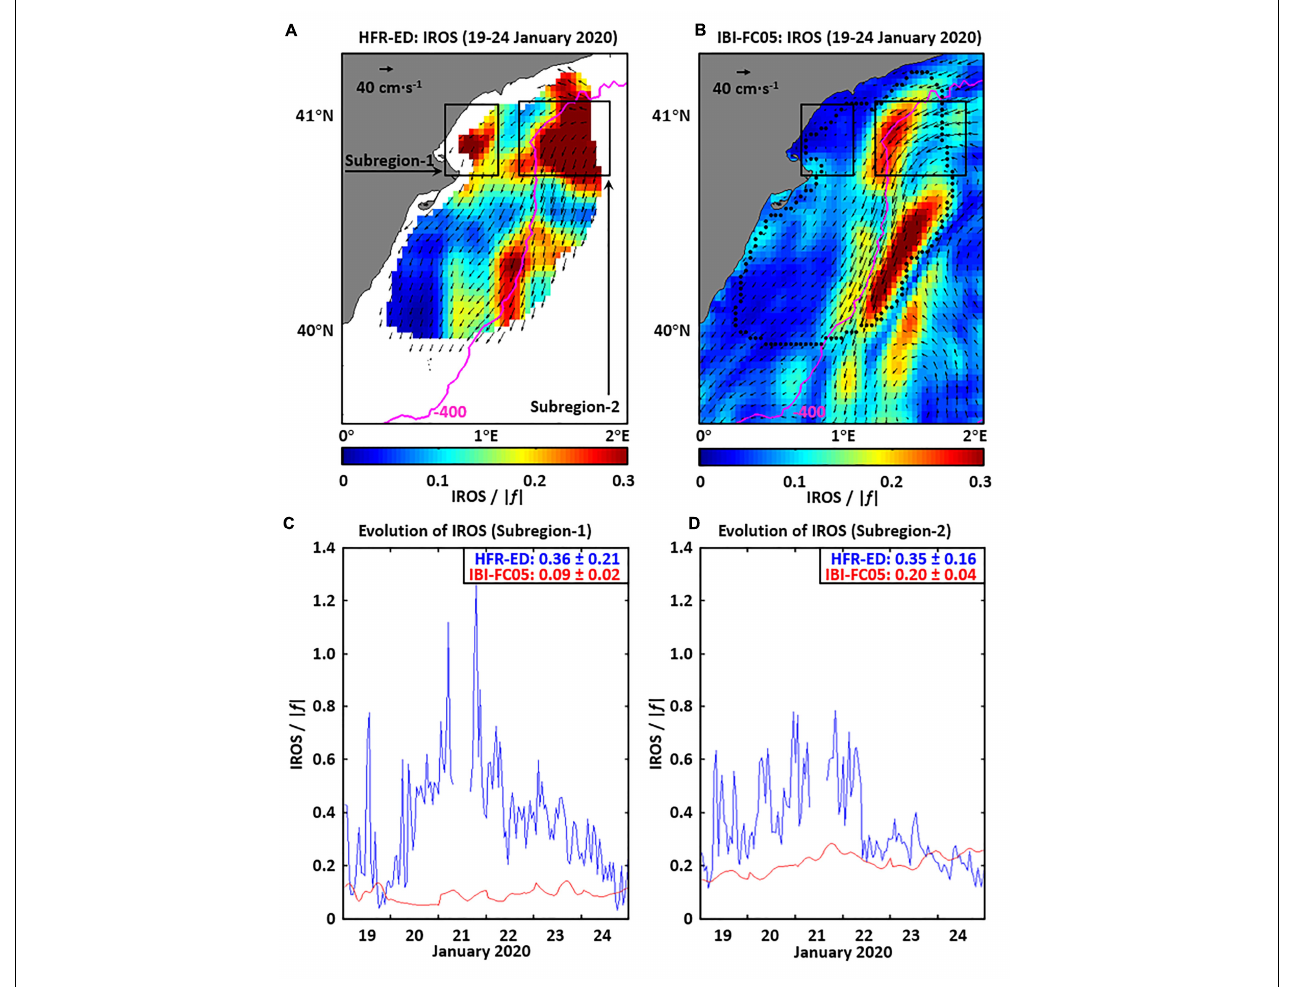
FIGURE 7 | Time-averaged maps of Instantaneous Rate of Separation (IROS) for the 6-day period (January 19–24, 2020) as derived from HFR hourly current estimations (A) and IBI model outcomes five days ahead (B) . (C,D) Temporal evolution of IROS diagnostic, spatially averaged over two different subregions within the common domain (denoted with black boxes in panel (A) : in the northern periphery of ED mouth (C) and in north-easternmost sector (D) . IROS derived from HFR and IBI estimations are represented by blue and red lines, respectively.